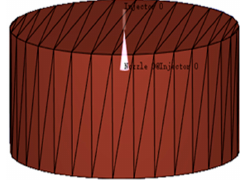
Figure 3. Computational grid. Table 2. Physical model.